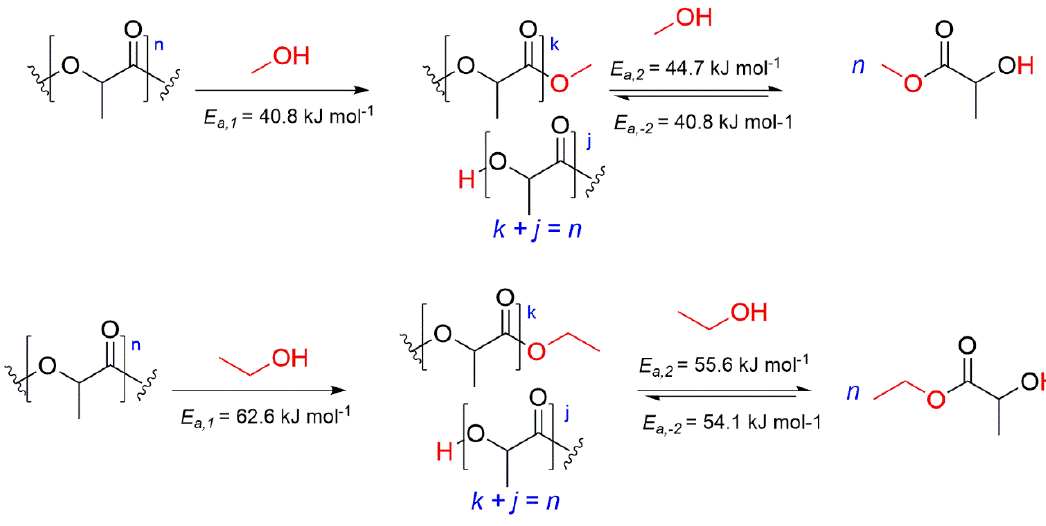
Figure 6. Simplified reaction scheme for PLA alcoholysis showing the activation energies for each step.